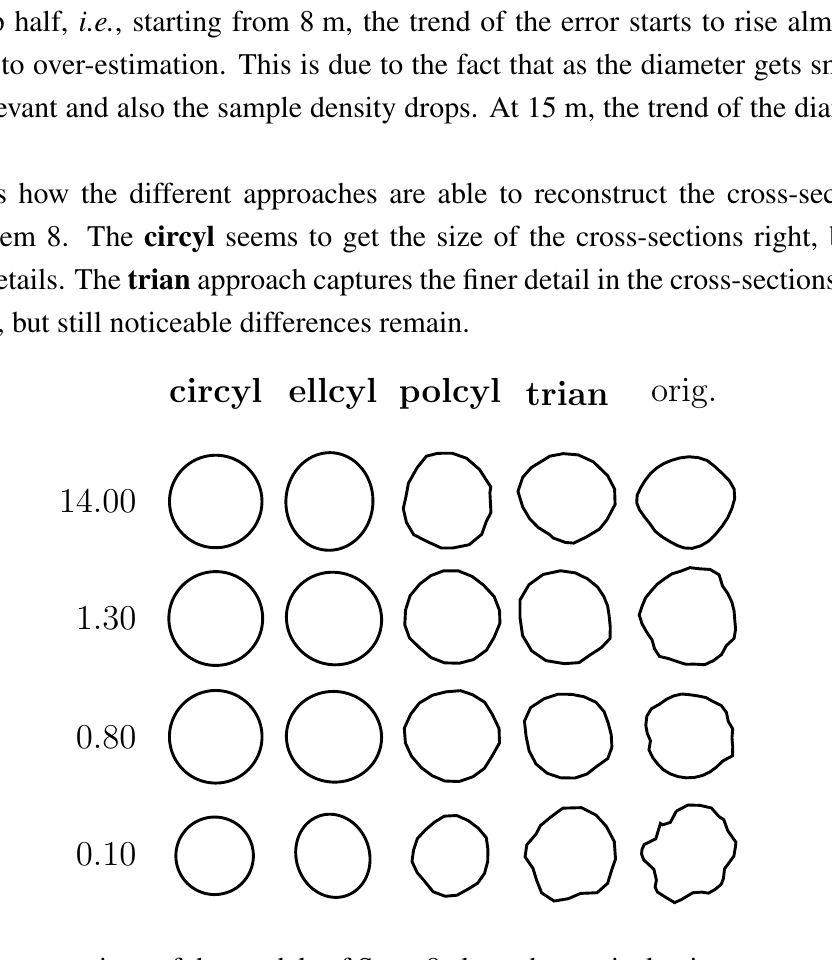
Figure 8. Cross-sections of the models of Stem 8 along the vertical axis, reconstructed from the noisy